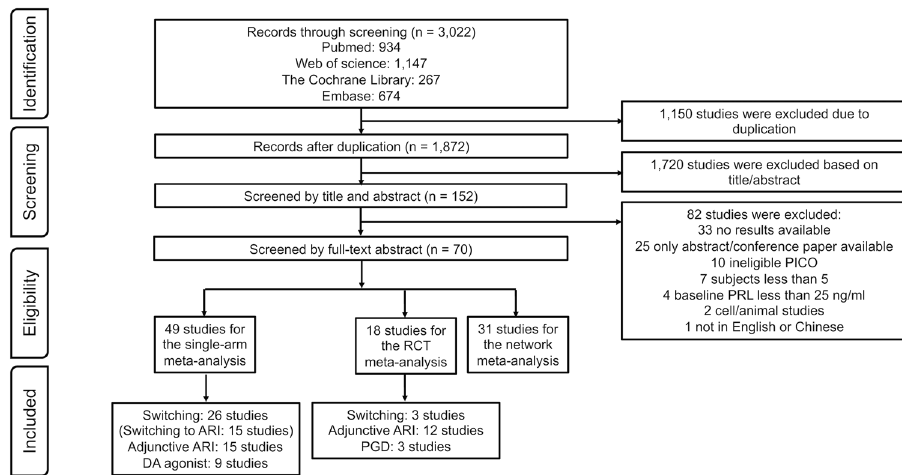
Fig. 1 Flow chart of included studies. RCT randomized controlled trials, ARI aripiprazole, DA dopamine agonist, PGD Peony-Glycyrrhiza